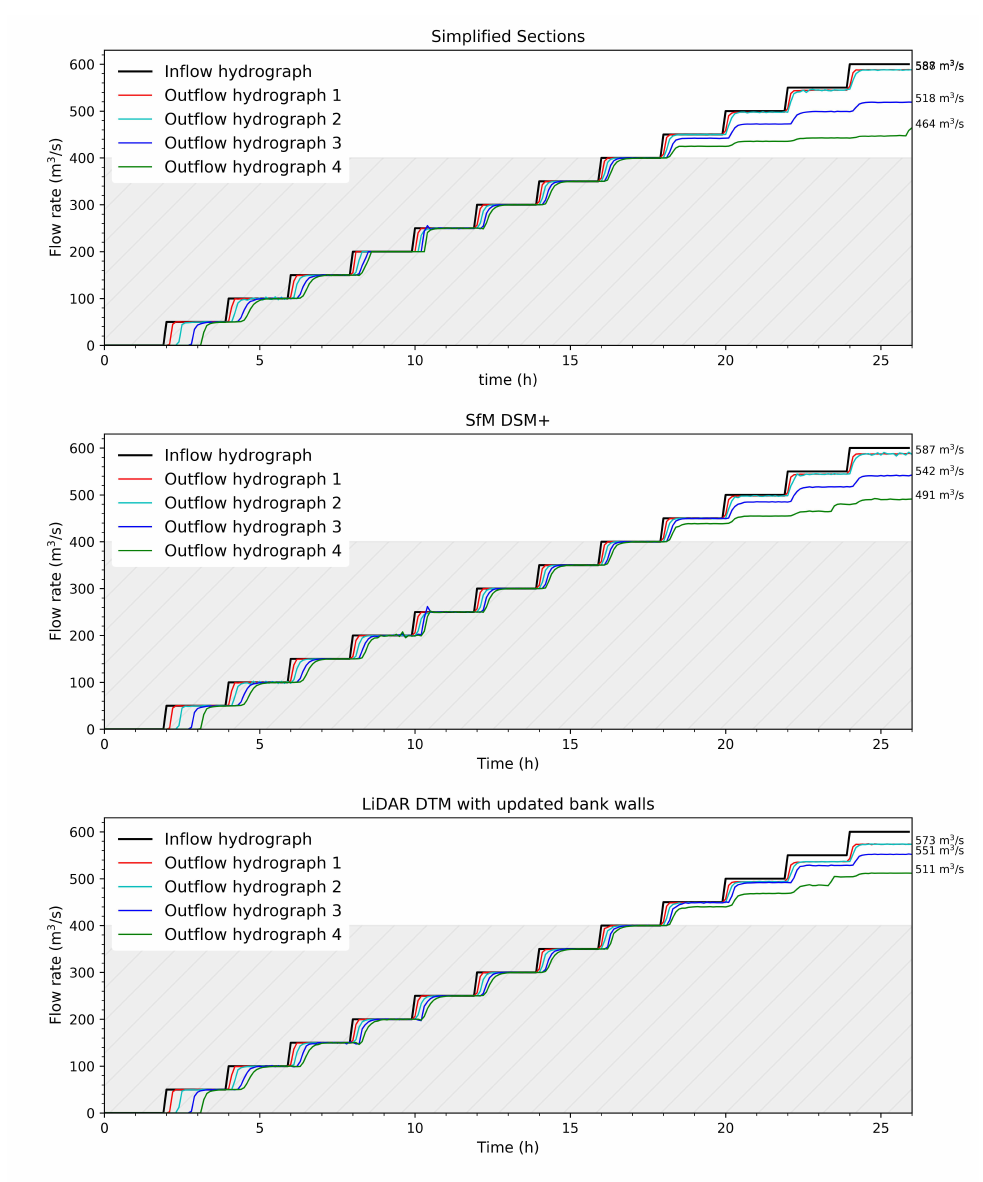
Figure 9. Flow rates computed using FLO-2D at four di ff erent points (see Figure 2) for an input flow step function with 50 m 3 / s increments (maximum input rate 600 m 3 / s) in the simulations based on simplified sections extracted from the SfM DSM, SfM DSM + , and LiDAR DTM with bank walls updated using the SfM DSM. The shaded area highlights the flow rate range without